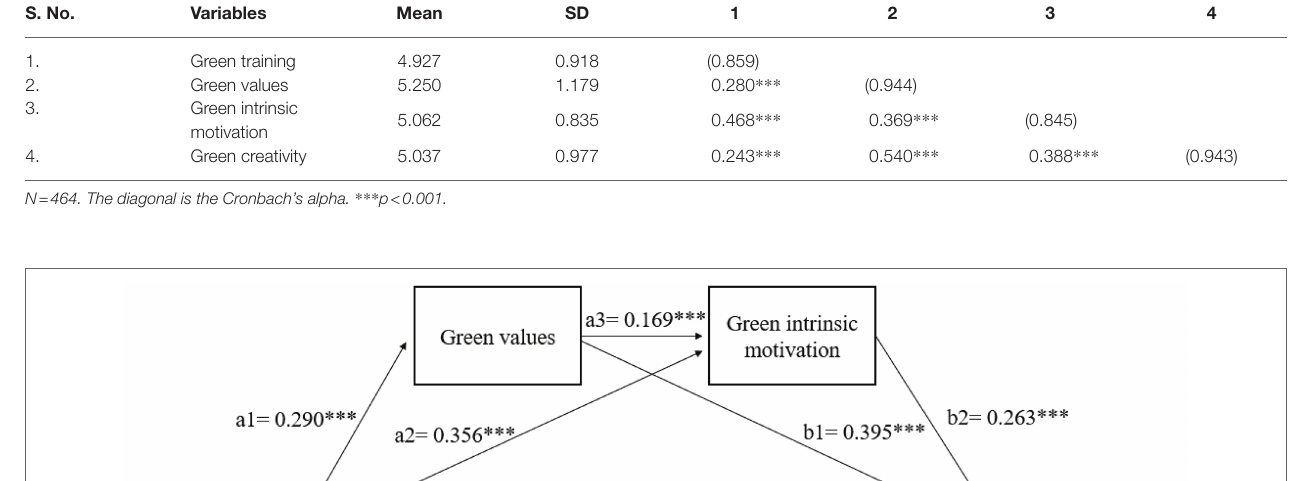
TABLE 2 | Descriptive statistics and correlations between variables. S. No.